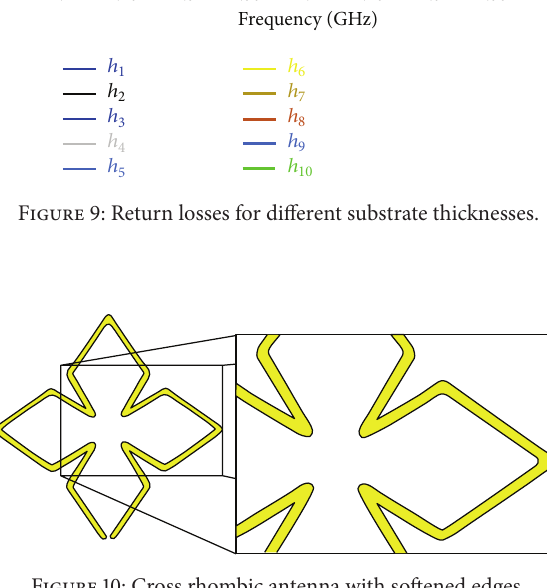
Figure 10: Cross rhombic antenna with softened edges.